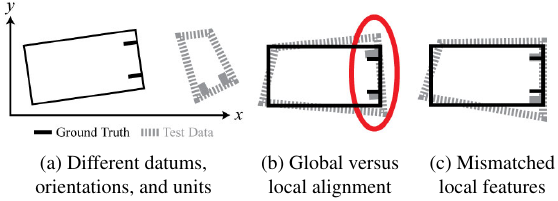
Figure 1. Challenges in assessing low quality point cloud data